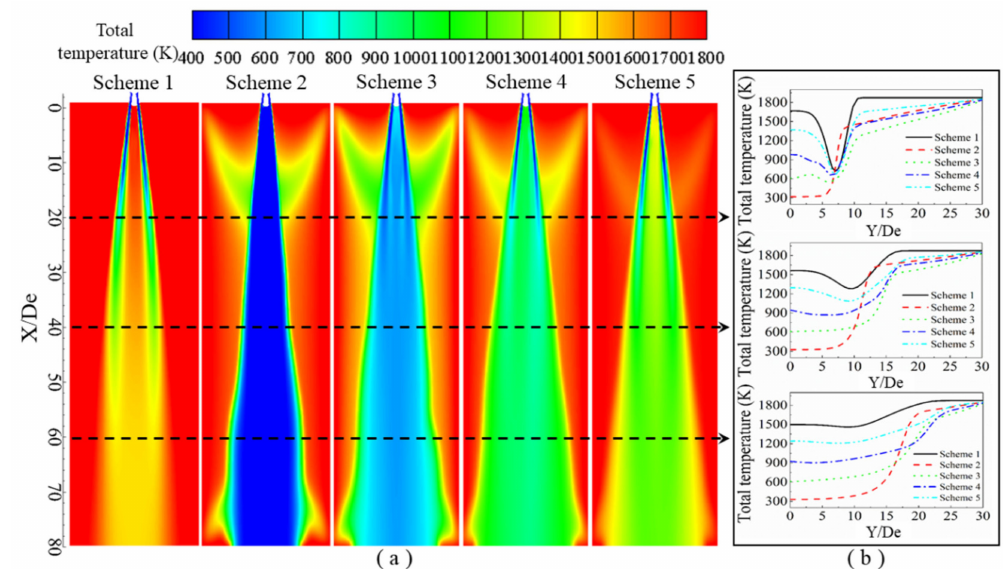
Figure 12. Total temperature distribution of the supersonic jet produced by the lance tip. ( a ) Total temperature contours along the longitudinal section, and ( b ) total temperature distribution as a function of the radial